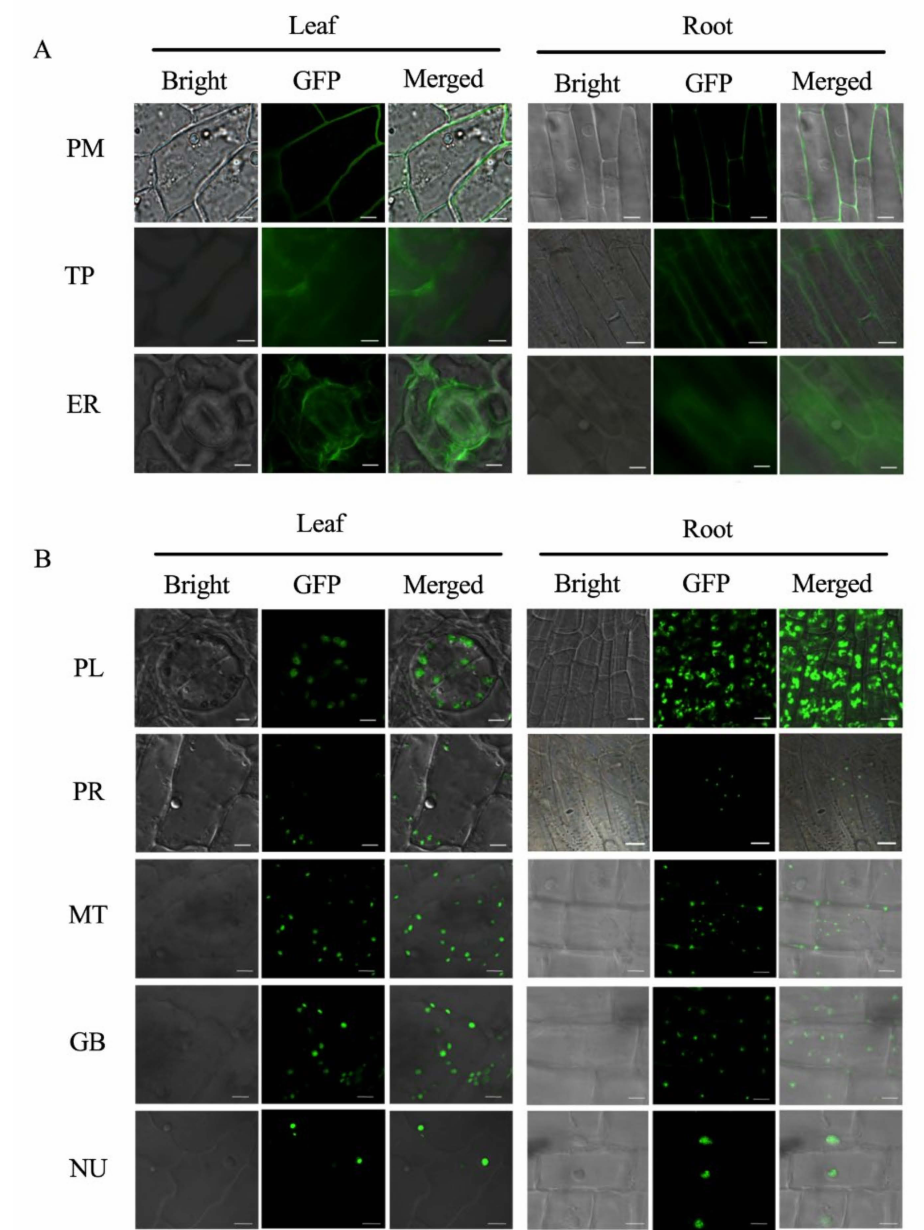
Figure 2. Localization of the eight organelle markers in cotton cotyledons and roots using the four- component BSMV system. ( A ) Subcellular localization of plastids, peroxisomes, mitochondria, Golgi body, and nucleus showing punctate cells; ( B ) subcellular localization of the plasma membrane, tonoplast, and endoplasmic reticulum showing lamellar structures. The scale bar is 5 µ m. PM: plasma membrane; TP: tonoplast; ER: endoplasmic reticulum; PL: plastid; PR: peroxisome; MT: mitochondria; GB: Golgi body; NU: